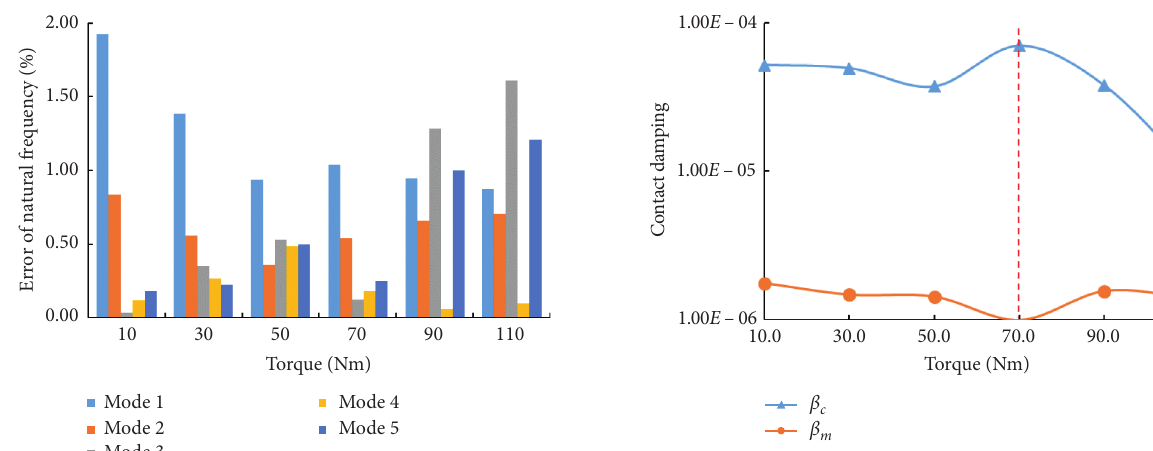
Figure 12: Error of natural frequency for five mode shapes using 1mm thin-layer element.